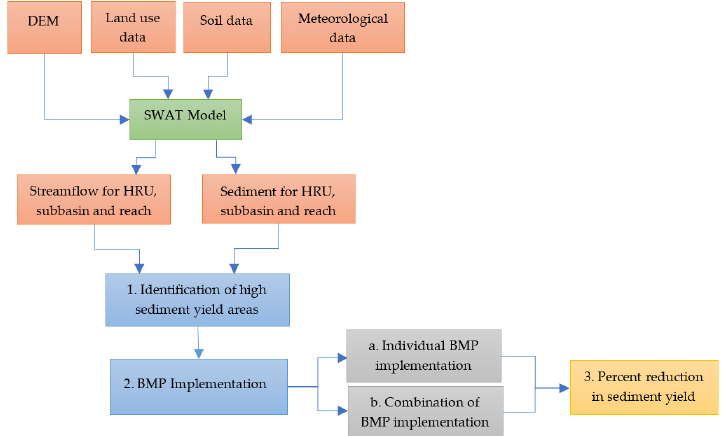
Figure 2. Flow chart showing SWAT methodology for runoff and sediment simulation.